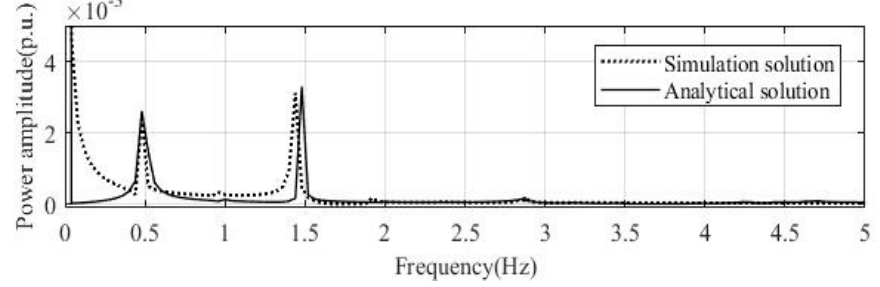
Figure 12. Spectrums obtained from the calculation data and the simulation data.